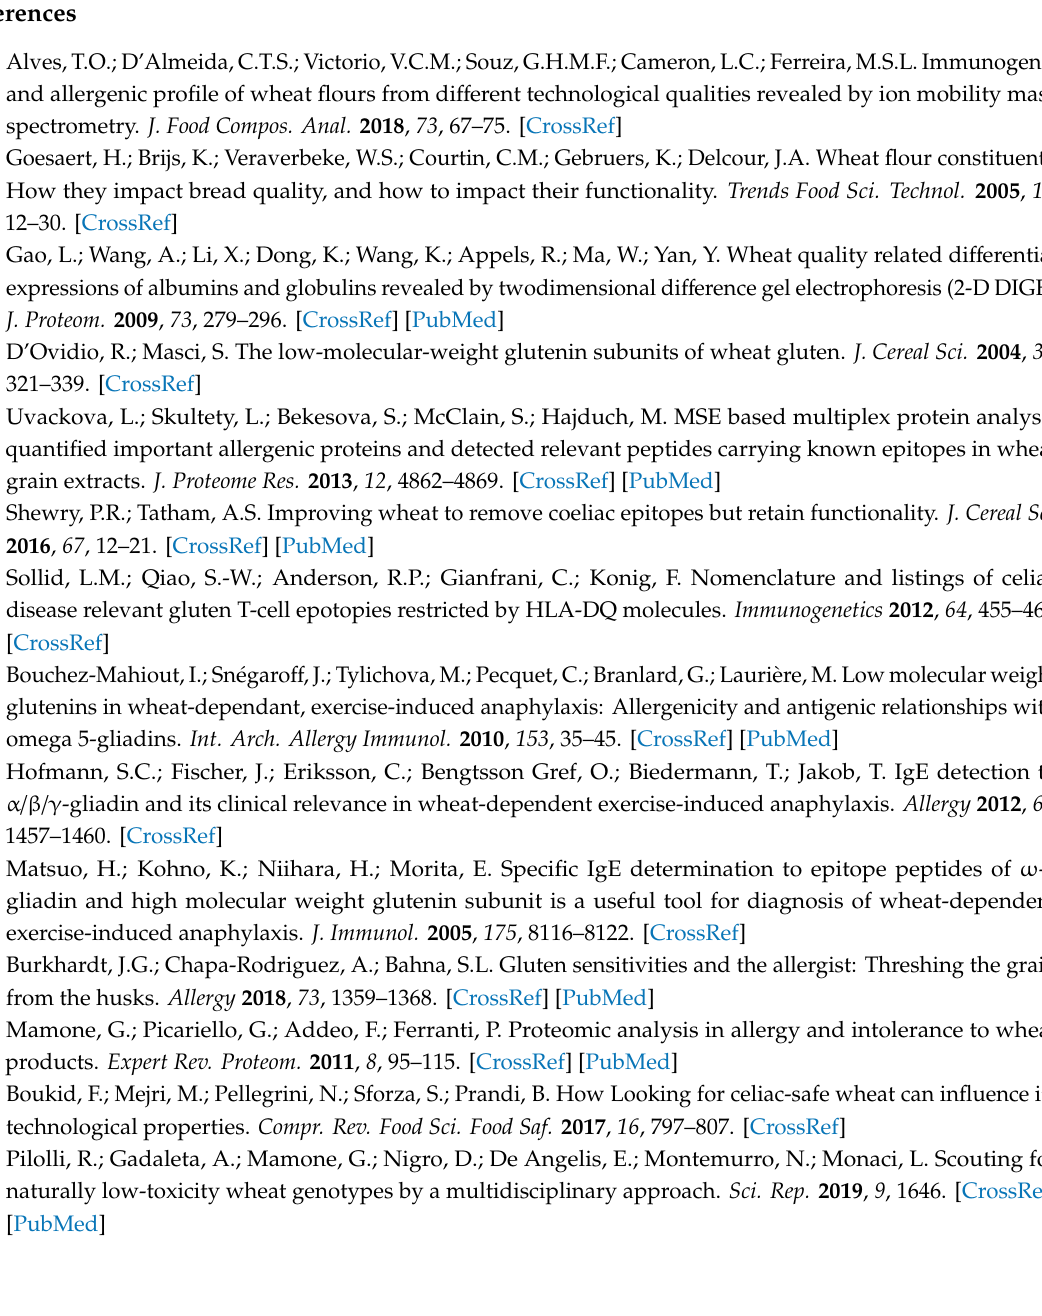
Figure S1: Comparison of the total protein content assayed in all protein fractions collected for each genotype. Figure S2: SDS-PAGE of the three protein fractions F1 (a), F2 (b), F3 (c) for all five wheat genotypes. Fractions F1 and F2 were separated on a 4-20% gradient gel, whereas the fraction F3 was separated on a 12% gel. Table S1: Full list of proteins and peptides identified in Osborne protein fractions (multiconsensus of peptide pools obtained with CHY and THE / CHY); Table S2: Full list of GD resistant peptides; Table S3: Full list of CD epitopes detected and their distribution among di ff erent genotypes and set of samples. Table S4: Full list of WA epitopes detected and their distribution among di ff erent genotypes and sets of